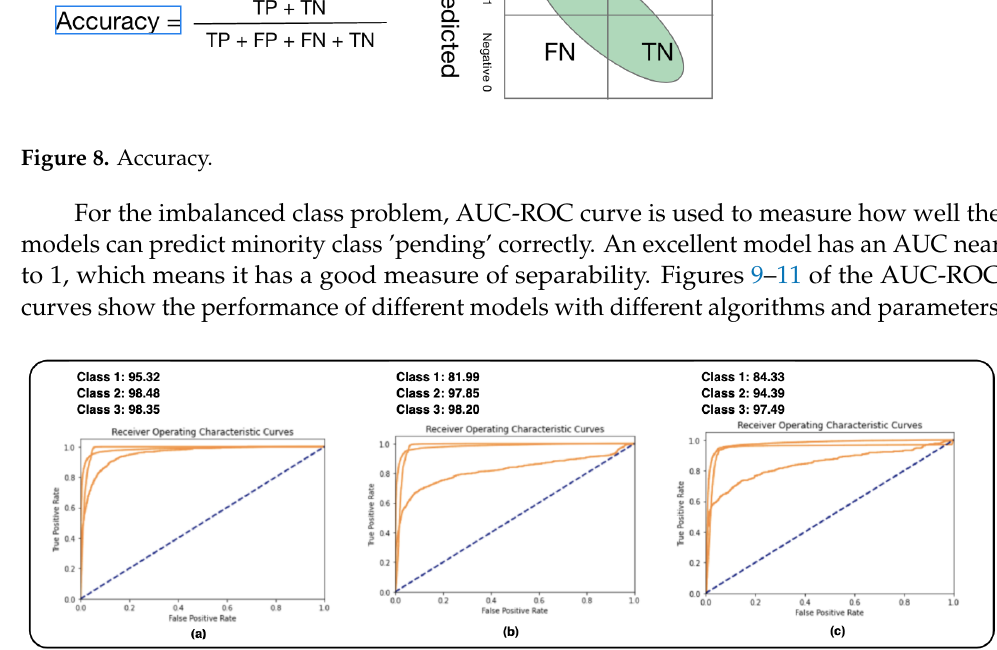
Figure 9. AUC-ROC curve performance of three MLP models with different parameters. ( a ) MLP with Tanh as an activation function with 3 hidden layers (25, 50, 25). ( b ) MLP with Relu as an activation function with 3 hidden layers (50, 100, 50). ( c ) MLP with Identity as an activation function with 3 hidden layers (25, 50,